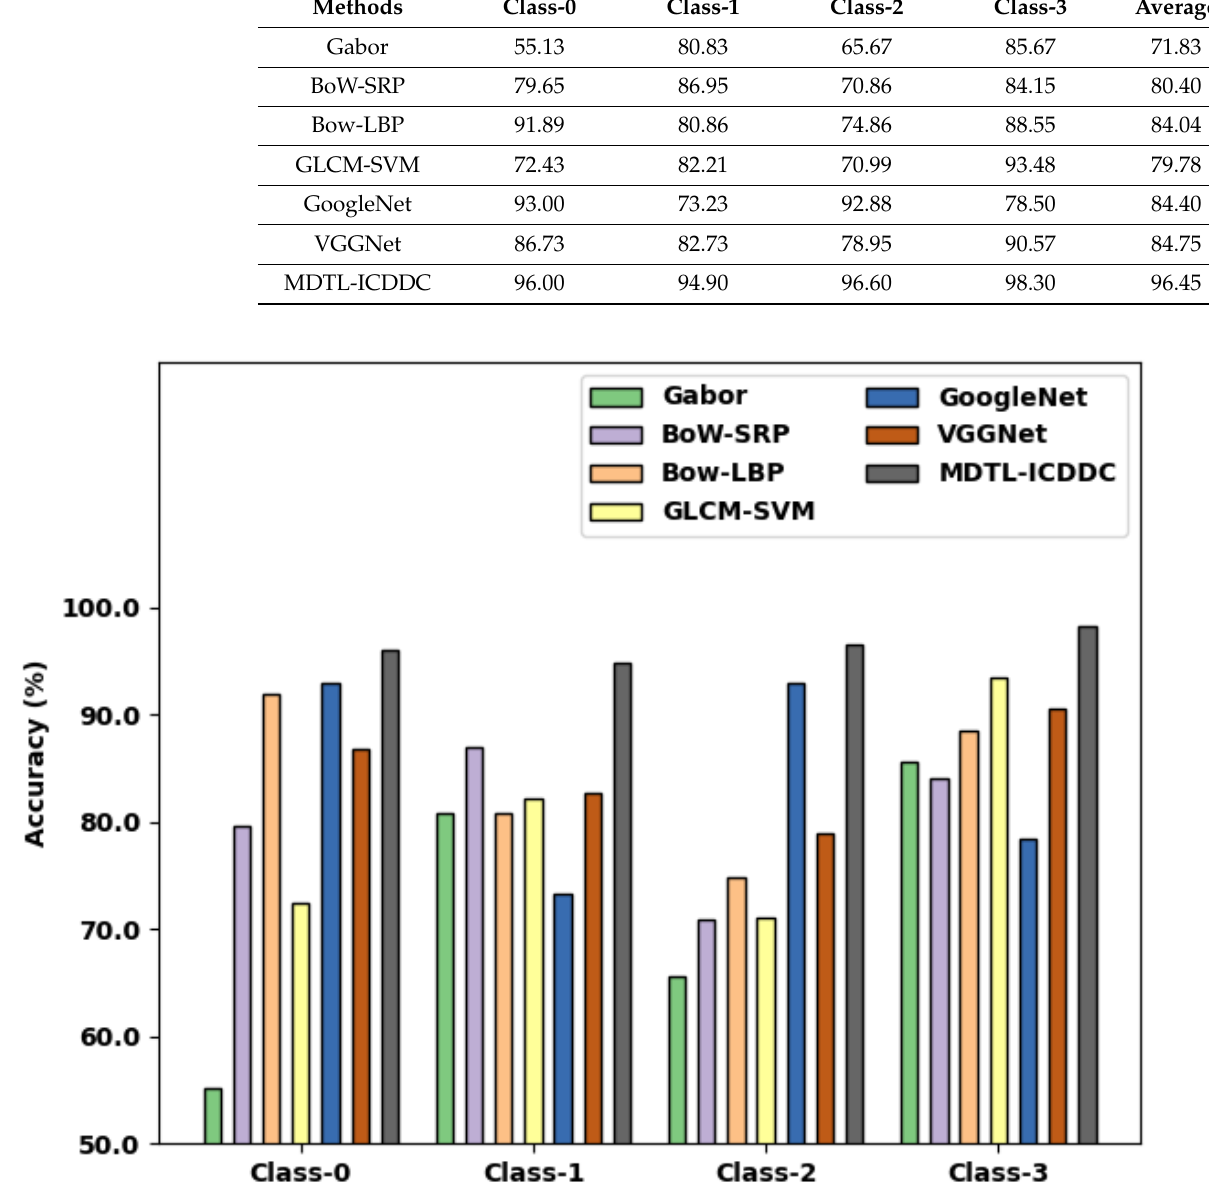
Figure 13. Accuracy analysis of MDTL-ICDDC technique under various classes.